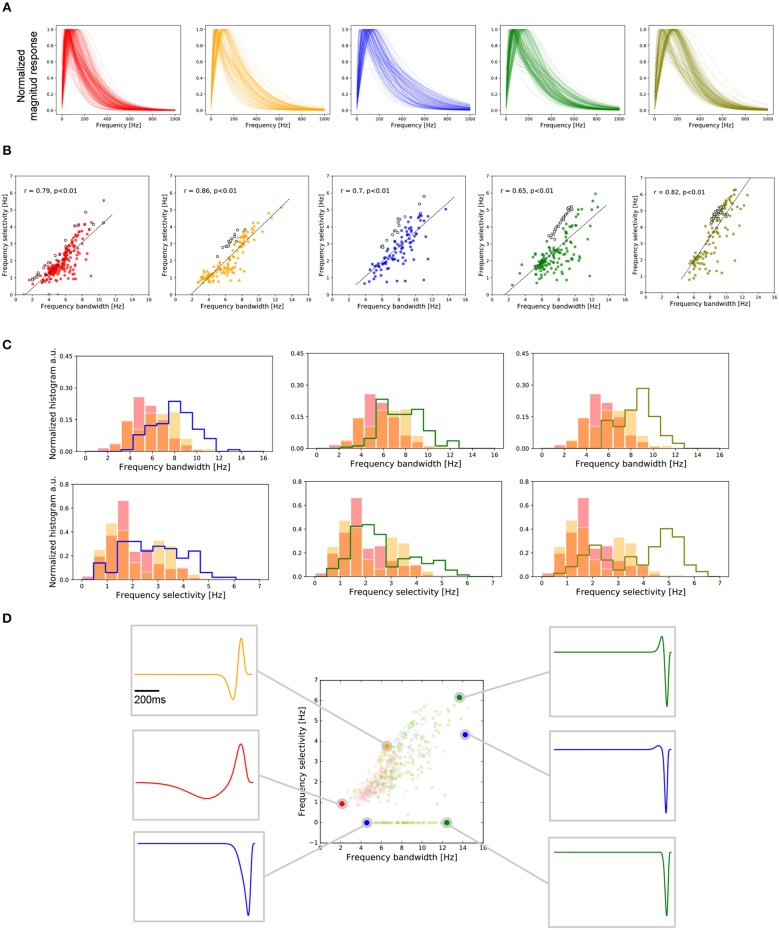
Frequency selectivity in central and peripheral RGCs. (A) Frequency response of the RGCs, temporal profiles of cells from the two central retina preparations (red and orange) and from the peripheral retina preparations (blue, green, and olive). (B) Covariation of the temporal frequency bandwidth and frequency selectivity for each retina preparation for all the RGCs recorded. Each preparation is accompanied by the respective regression indicating the level of correlation between these two values. (C) Histograms of the frequency bandwidth (top) and frequency selectivity (bottom) of all the recorded RGCs in the five retina pieces. Each column compares the centers against each of the peripheries. (D) Condensed representation of the five preparations analyzed. For the six selected, we show the temporal profile matching the frequency bandwidth and frequency selectivity values. Frequency selectivity is related to the cell biphasic-index. On the other hand, the response latency given by peak-time and zero-cross parameters is related to frequency bandwidth.